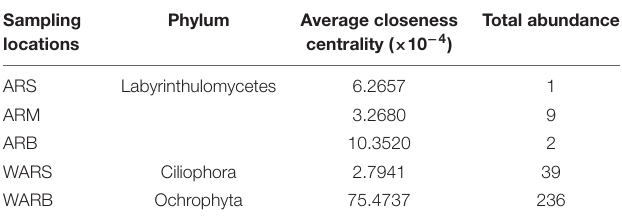
TABLE 5 | Top phylum (average closeness